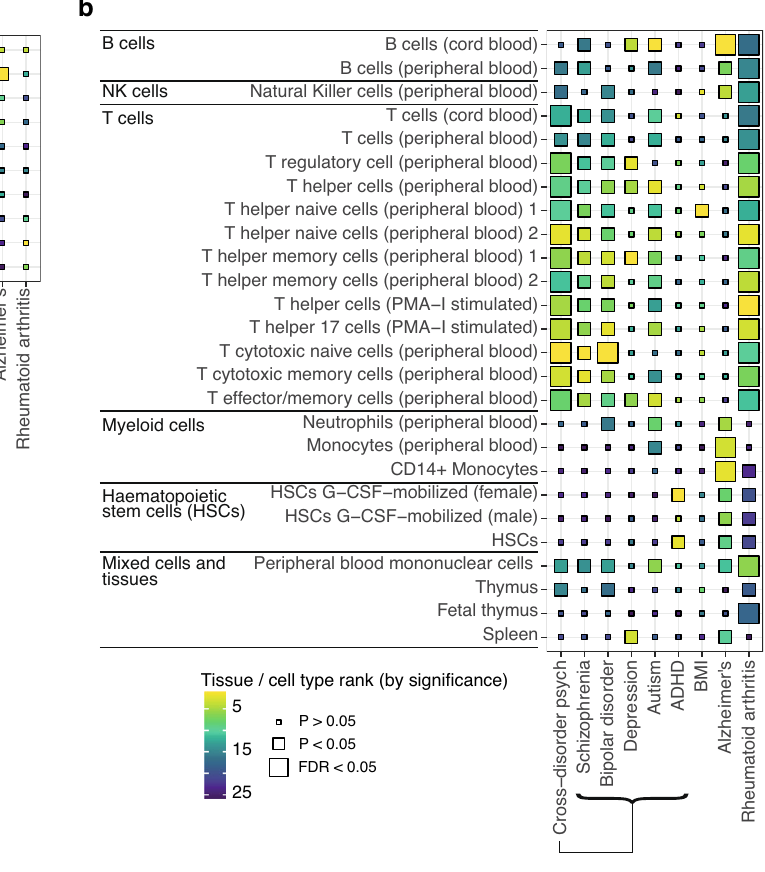
Fig. 2 | Cis-diagnostic risk enrichmentat epigeneticallyactivated sites in adult and fetal brain tissue and immune cells for 8 speci fi c disorders. For each of 5 mental health disorders (schizophrenia, bipolar disorder, major depressive dis- order [MDD], autism,and attentionde fi cit-hyperactivity disorder[ADHD]),and for each of 3 positive control disorders (obesity, Alzheimer ’ s disease and rheumatoid arthritis), enrichment of cis-risk variants at active regulatory elements (active promotersandenhancers)wastestedin a 10braintissuesamples(3fetal)and b 26 immune cell subsets and tissues (3 fetal) 54 . P -values are shown for the results of strati fi ed linkage disequilibrium score regression (s-LDSC) analysis (one-sided